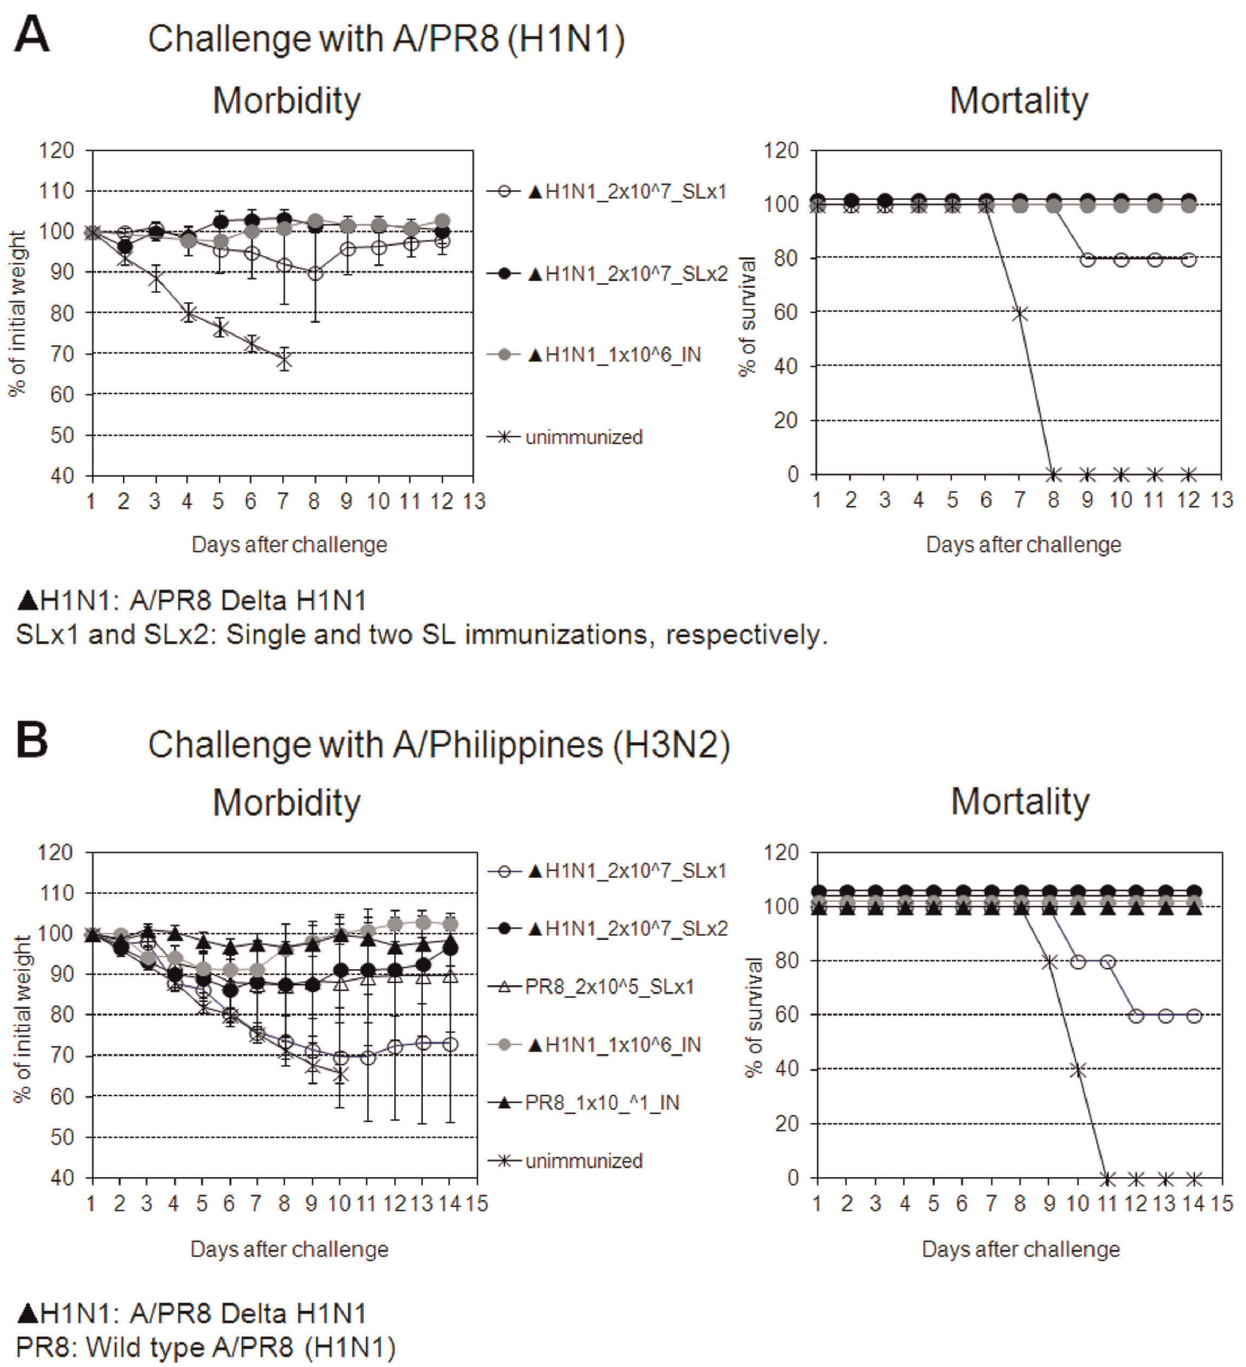
Figure 3. Induction of homotypic and HSI upon immunization with Delta H1N1. BALB/c mice were immunized IN or SL with different doses of Delta H1N1 ( m H1N1), given once (1x) or twice (2x) at 2-week intervals. Four weeks later, animals were intranasally challenged with 5 6 LD 50 of homologous mouse-adapted A/PR8 (Fig. 3A) or heterosubtypic mouse-adapted A/Philippines (A/P) H3N2 (Fig. 3B) virus. Morbidity and mortality were monitored daily. Data are expressed as mean (body weight or % survival) determined on groups of 5–10 mice. doi:10.1371/journal.pone.0039921.g003 LD 50 of the H5N2 virus was determined in mice for challenge passages (15 times) in BALB/c mice. After final passage, single experiment. plaque was isolated by three consecutive plaque purifications on MDCK cells, amplified in embryonated chicken eggs, and the